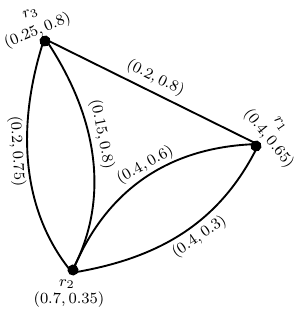
Figure 3.1: Pythagorean fuzzy multigraph Figure 4. Pythagorean fuzzy